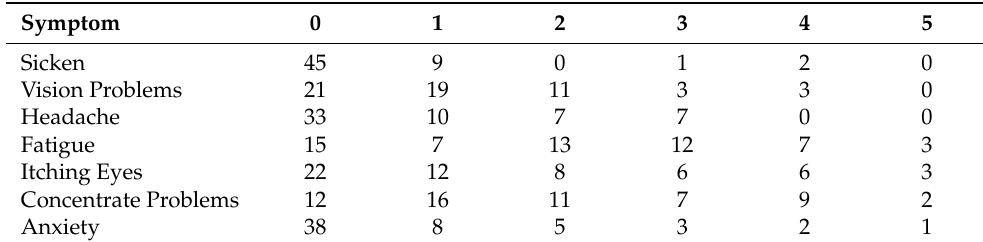
Table 2. Symptoms during the simulation.